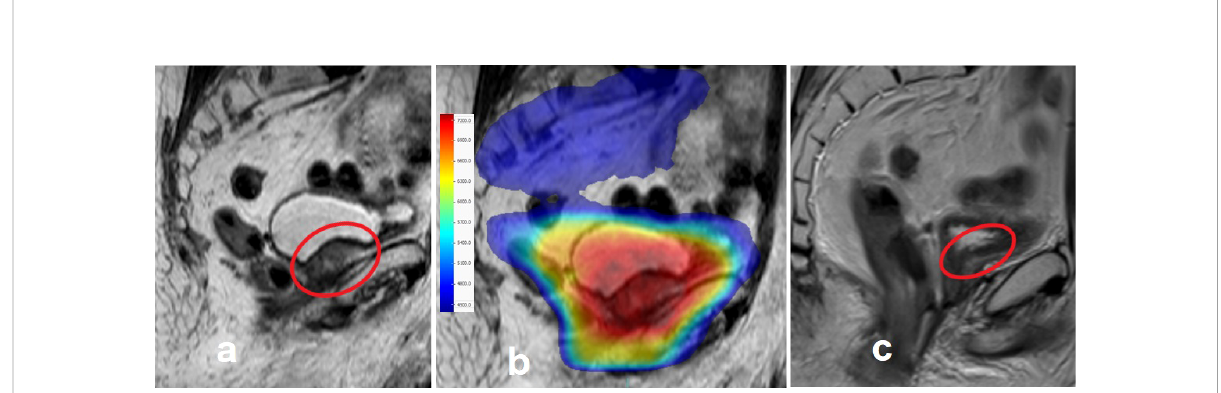
FIGURE 2 An exemplary case treated with MRI-guided prostate cancer radiotherapy. (A) Macroscopic prostate bed relapse near the intestines 15 years after radical prostatectomy. (B) The sum of dose distributions to the pelvic lymph nodes, prostate bed, and relapse area. (C) Total macroscopic regression of the tumor, 3 months after